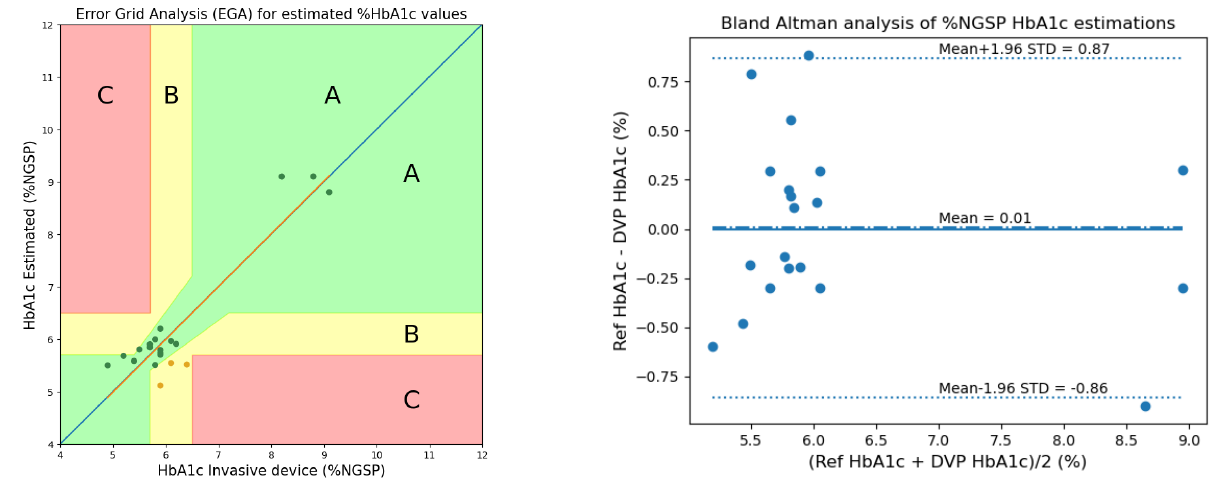
Figure 7. EGA and Bland–Altman analysis for HbA1c with the whole finger model (considering both ratio and value calibrations).